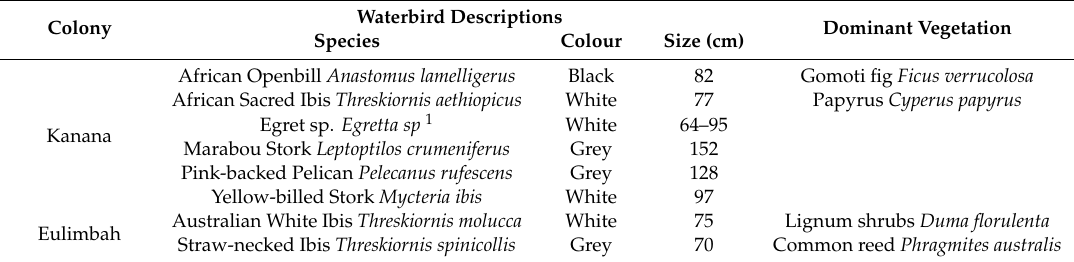
Table 1. Main waterbird breeding species (targets) in the two waterbird colonies, Kanana colony (Okavango Delta) and Eulimbah colony (Lowbidgee floodplain), counted using semi-automated methods, including their size and colour (important for detection), the dominant vegetation on which they nested (the background) and estimated number of each species in the two